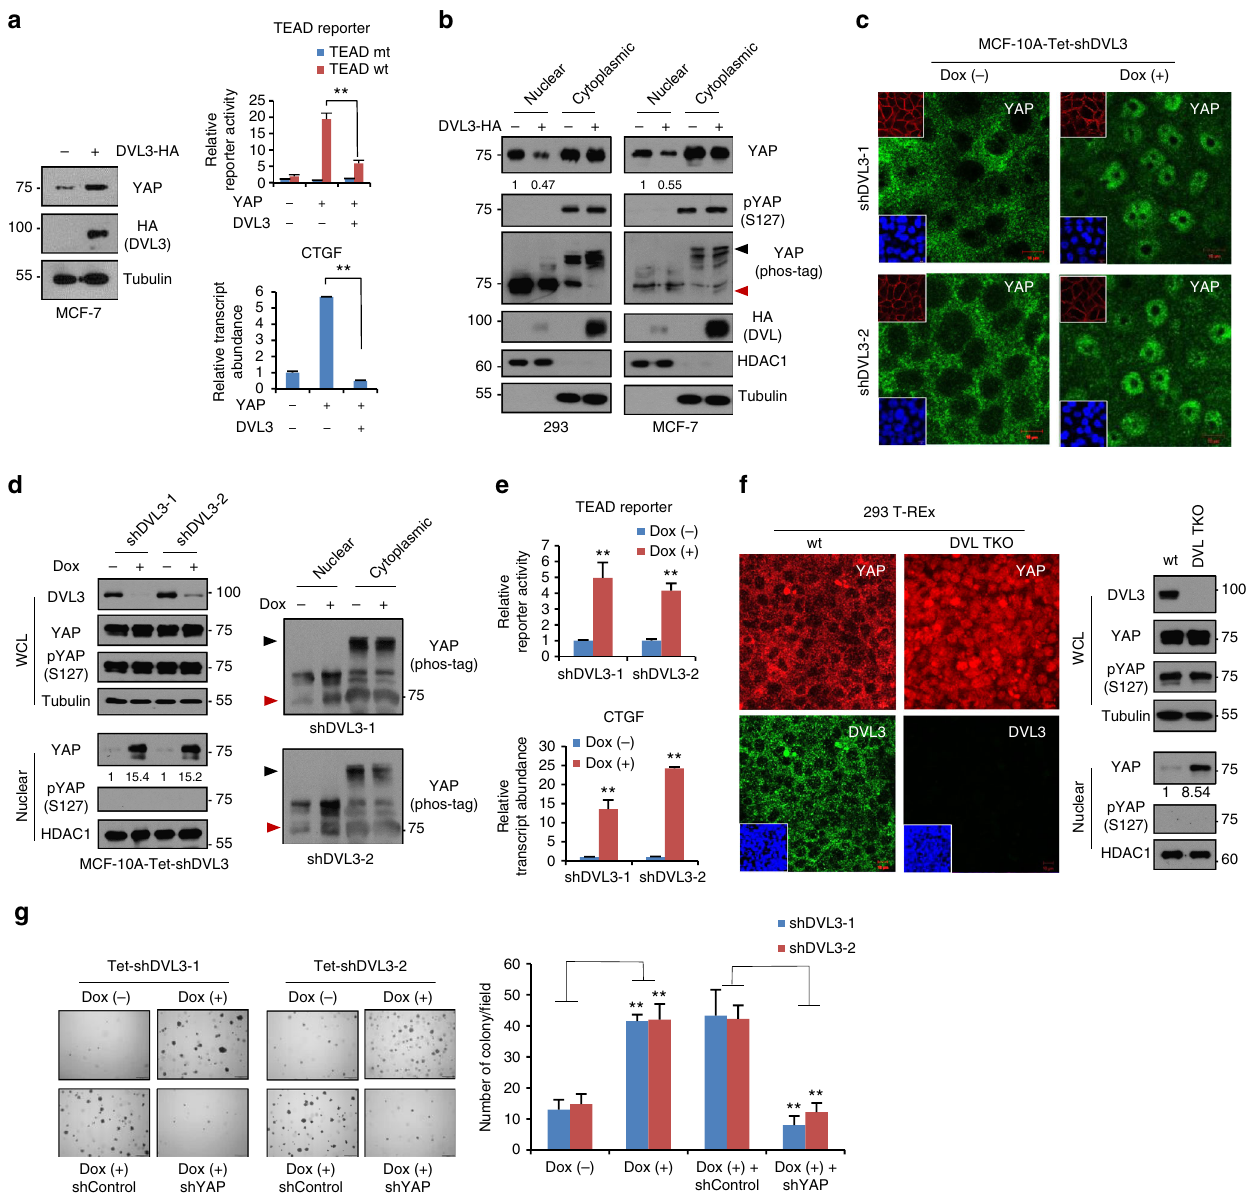
Fig. 2 DVL suppresses YAP nuclear abundance and TEAD transcriptional activity. a YAP was co-transfected with HA-DVL3 into MCF-7 cells, and protein abundance (left), TEAD reporter activity (right upper), and CTGF transcript abundance (right lower) were determined. Data of reporter assay and RT-PCR are normalized to negative control empty vector ( − ) and presented as mean ± SD. b The 293 and MCF-7 cells were transfected with DVL3, and protein abundance of YAP in nuclear and cytoplasmic fraction was determined by immunoblot analysis. YAP phosphorylation status in cytoplasmic and nuclear fraction was determined by pS127-YAP antibody and mobility shift on a phos-tag gel. Red arrowhead indicates active YAP on a phos-tag gel. Tubulin and HDAC1 served as loading controls of cytosolic fraction and nuclear lysates, respectively. Relative nuclear YAP abundance compared to control was measured by ImageJ. c , d Inducible knockdown of DVL3 increases nuclear YAP abundance. The MCF-10A cells expressing tetracycline-inducible shRNA against DVL3 were generated with lentiviral system, and endogenous YAP localization and abundance without or with doxycycline (Dox) were determined by immuno fl uorescence ( c ) and immunoblot analysis from whole-cell lysate (WCL) and nuclear fraction ( d ). The cells were serum-starved for 16 h before harvest. Tubulin and HDAC1 served as loading controls of cytosolic fraction and nuclear lysates, respectively. e DVL3 was knockdowned with doxycycline (Dox), and the TEAD reporter activity (upper panel) and CTGF transcript abundance (lower panel) were determined by reporter assay and qRT-PCR, respectively. f The wt and DVL-TKO cells were cultured in con fl uent condition and subcellular localization of endogenous YAP and DVL3 were determined by confocal microscopy (left panels) and immunoblot analysis (right panels). The cells were serum-starved for 16 h before examination. Inset, DAPI nuclear stain; Scale bar, 10 μ m. g Knockdown of DVL3 increases anchorage-independent growth of MCF-7 cells. The MCF-7 cells expressing inducible shRNA for DVL3 were seeded onto a soft agar without (Dox-) or with (Dox + ) doxycycline in combination with shControl or shYAP for 3 weeks. The colonies were stained with crystal violet and quanti fi ed. Data presented as mean ± SD, n =